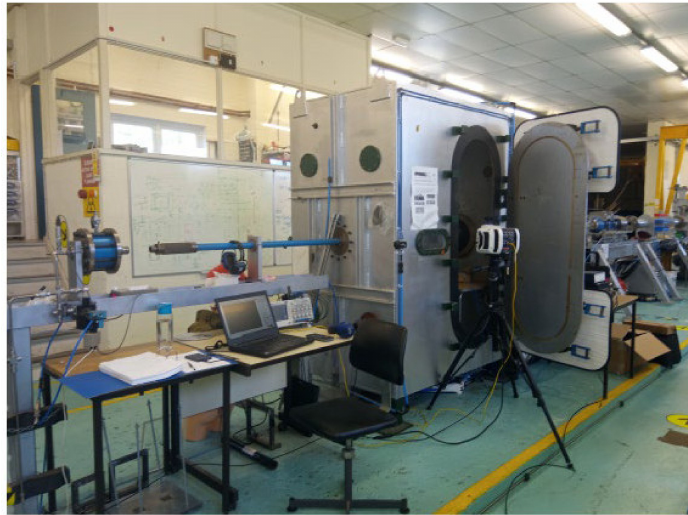
Figure 2. Picture of the setup for the gas gun and chamber.